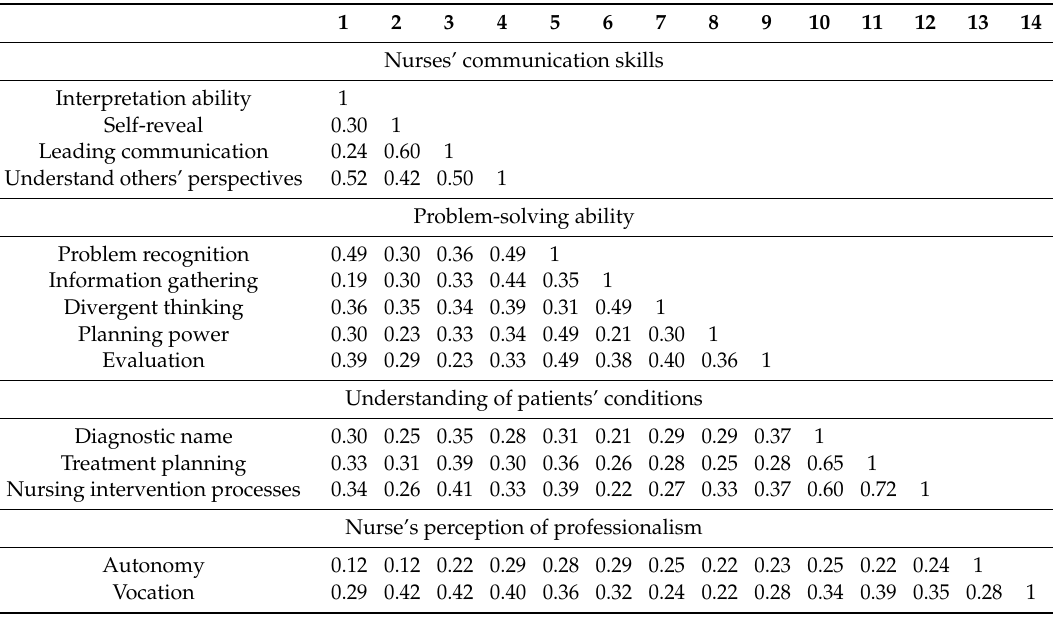
Table 3. Correlations between the observed